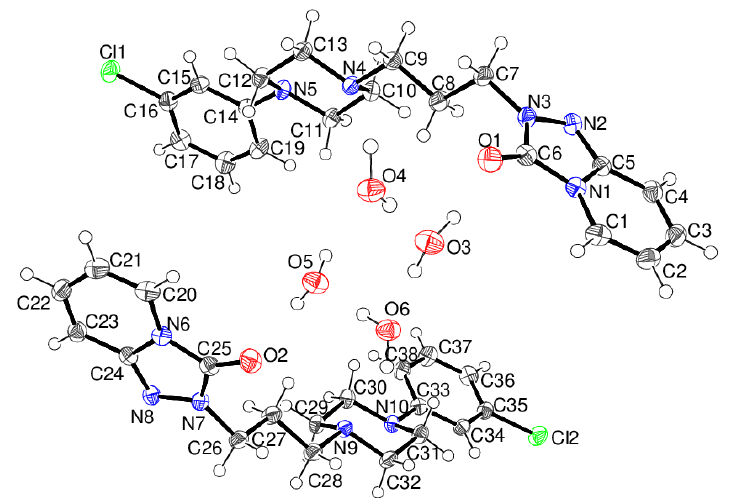
Figure 4. The molecular structure of γ -C 19 H 22 ClN 5 O·2H 2 O showing 50% displacement ellipsoids. Hydrogen-bond geometrical data for the γ polymorph are listed in Supplementary